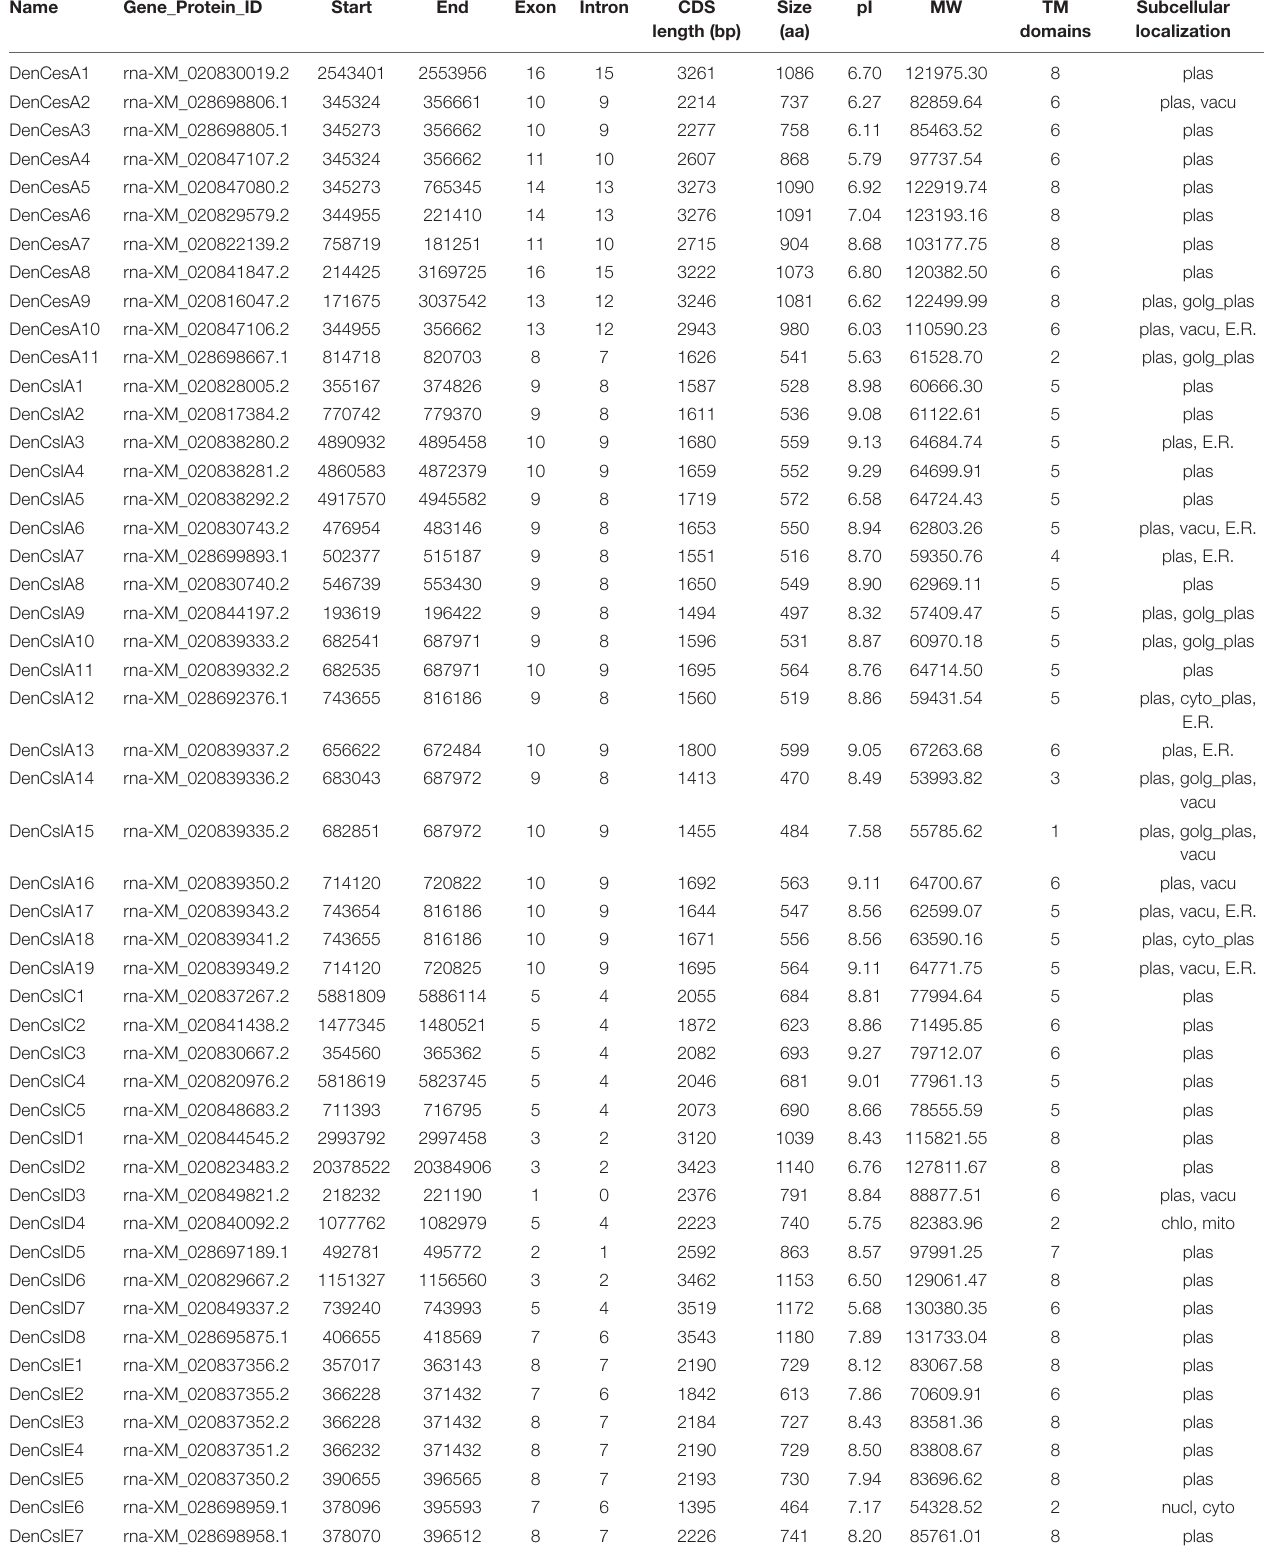
TABLE 1 | Physical and molecular characteristics of Cellulose synthase superfamily genes in D. officinale